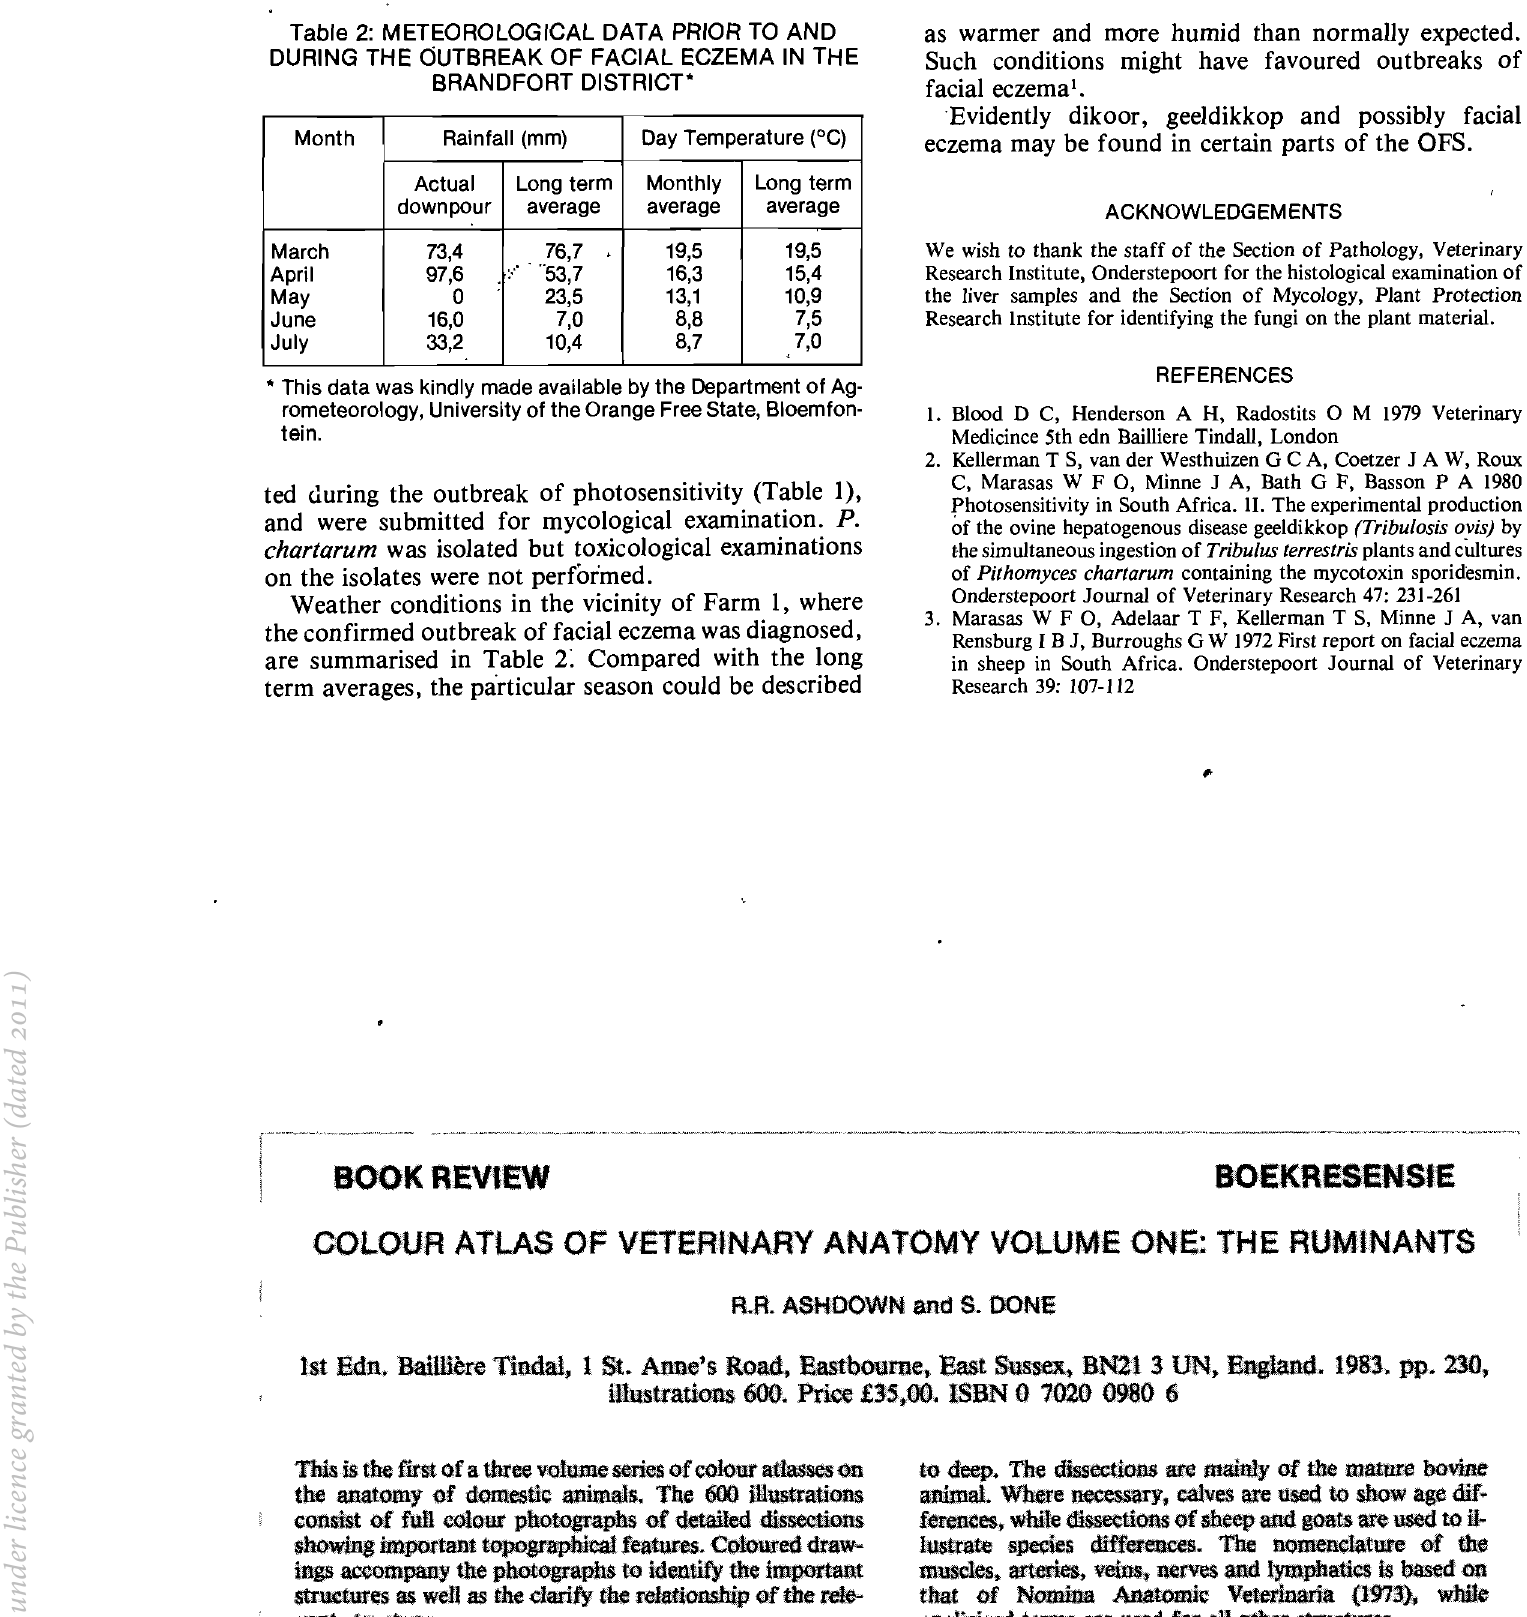
Table 2: METEOROLOGICAL DATA PRIOR TO AND DURING THE OUTBREAK OF FACIAL ECZEMA IN THE BRANDFORT